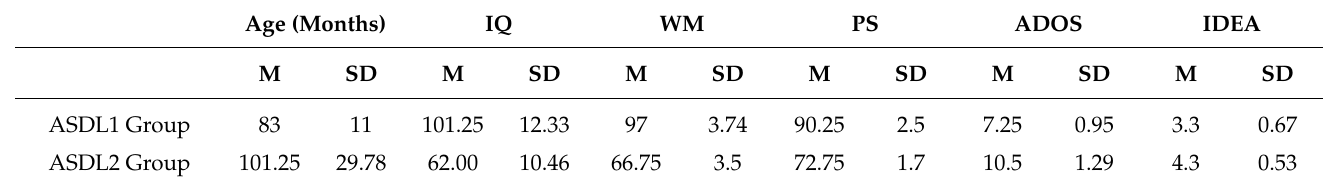
Table 1. Participants’ characteristics: ASDL1 Group and ASDL2